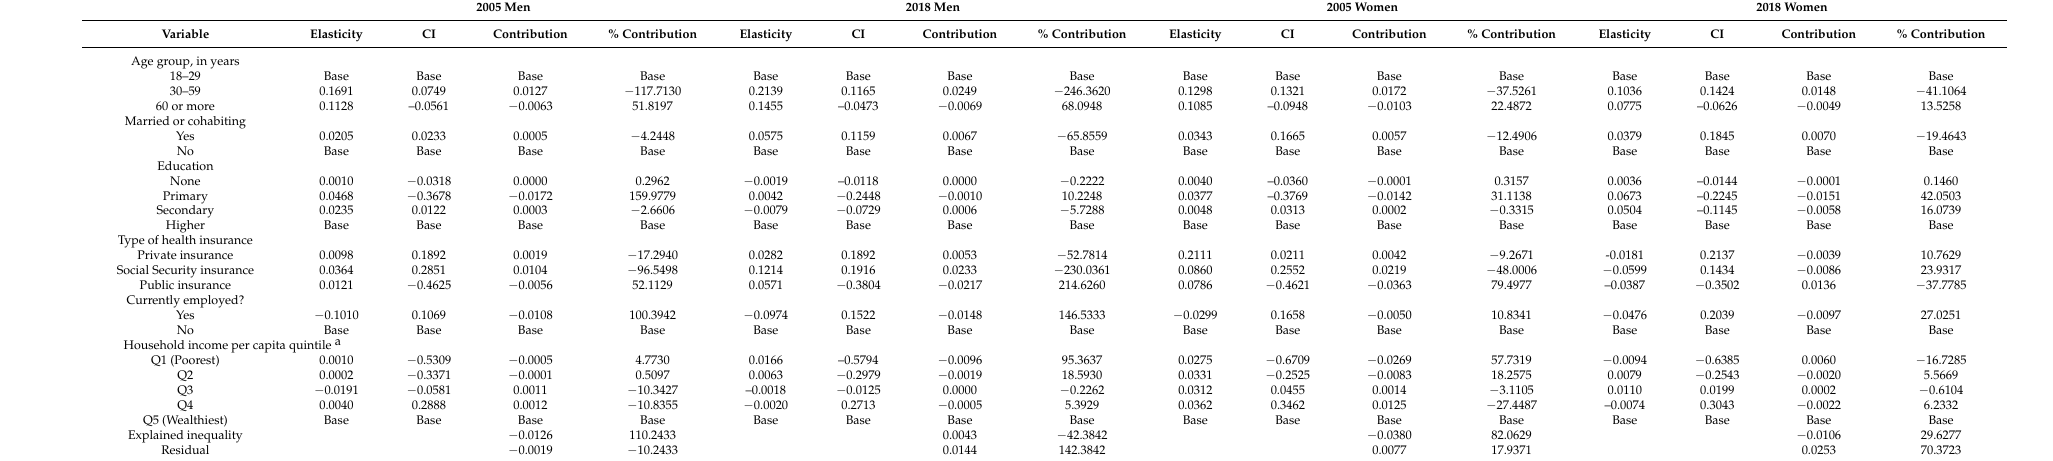
Table 2. Decomposition of Erreygers concentration